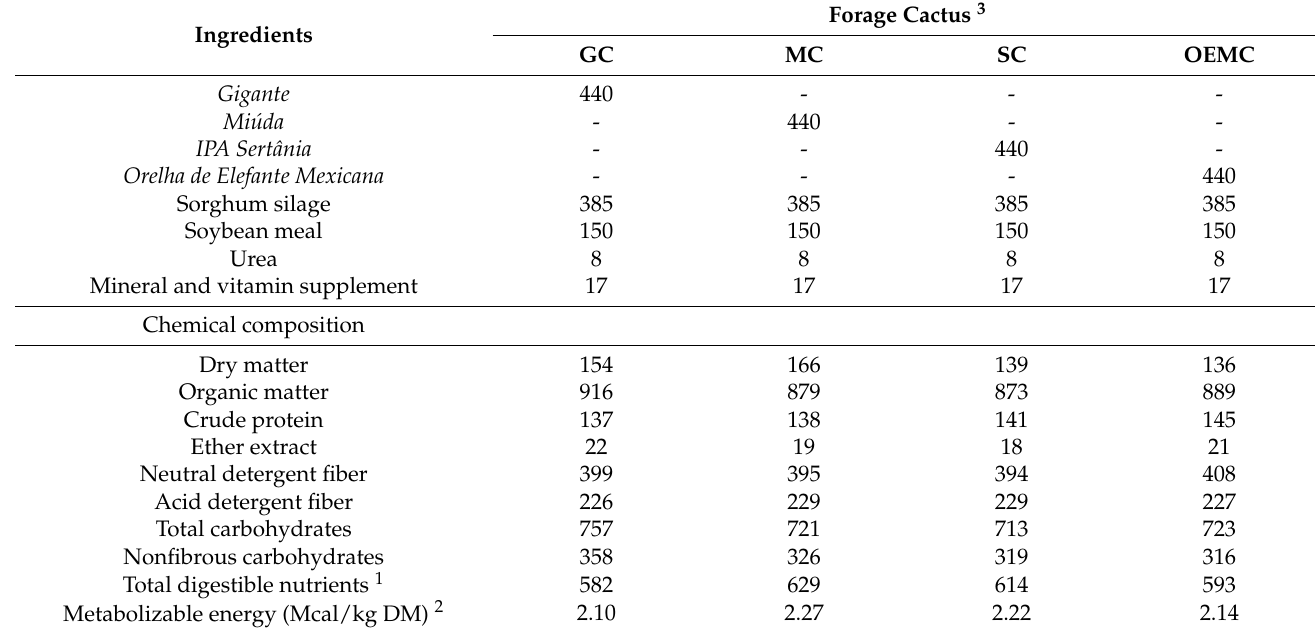
Table 2. Ingredients and chemical composition of the experimental diets (g/kg of DM unless otherwise stated).